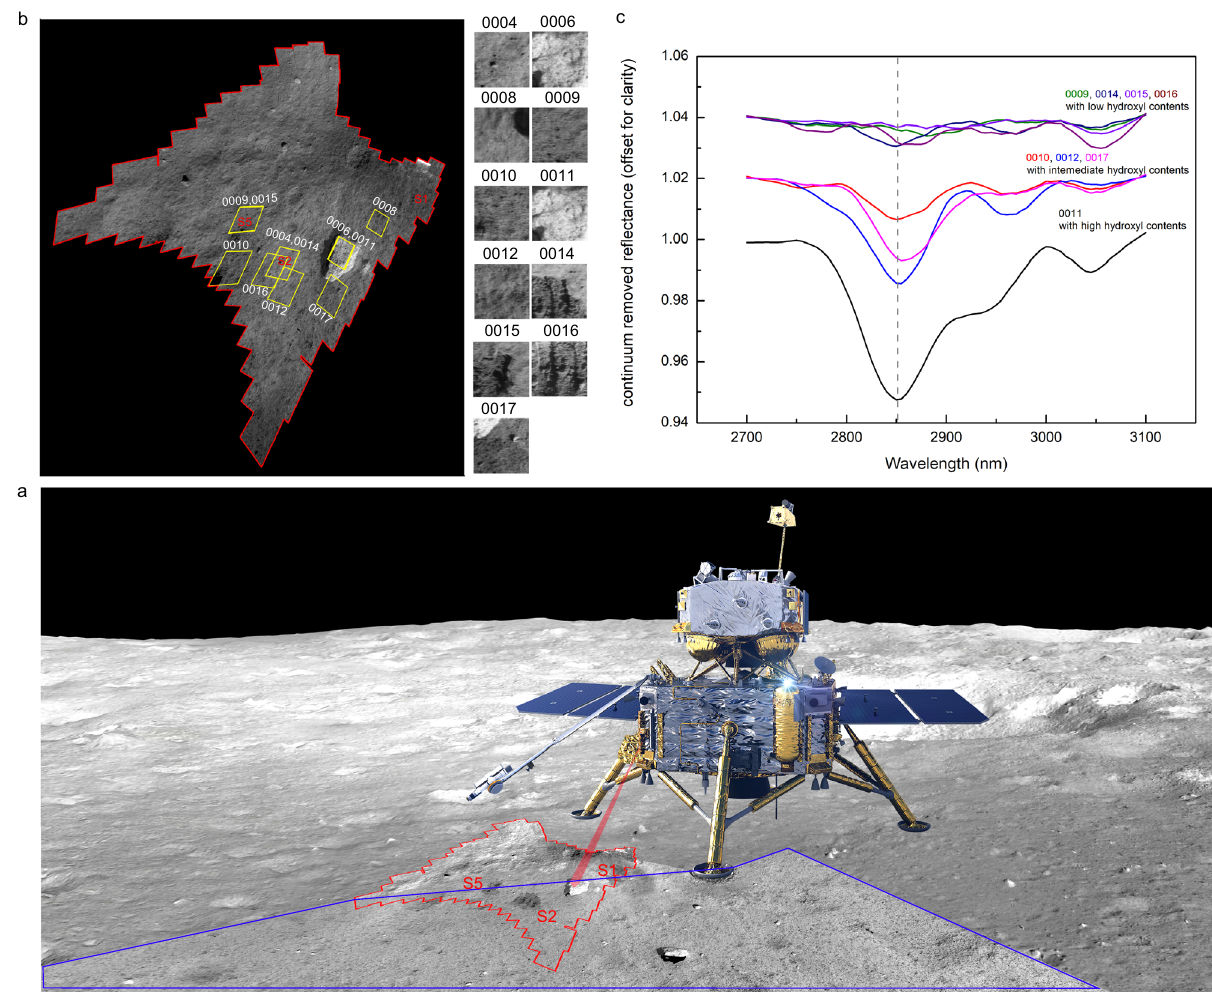
Fig. 1 Schematic diagram of the lunar mineralogical spectrometer (LMS) spectral data collection on the lunar surface and the 2700 – 3100nm absorption features of Chang ’ E-5 in situ spectra. a The area marked by the red line is the full view of LMS, S1, S2, S5 are the scoop sampling points, the blue box identi fi es the imaging area of the panoramic camera and the base image is from landing camera. b detailed positions and images of the LMS 11 Full-Bands Observation (FBO) detections. LMS operated twice at the S2 sampling point (detection number: 0004 and 0014), S5 sampling point (detection number: 0009 and 0015) and the large rock (detection number: 0006 and 0011) in the fi eld of view; the base map is composed of 180 images obtained by the LMS Full-View Scanning and Multispectral Observation (FVSMO) detections with a center wavelength of 750nm (More details see “ Methods ” ). c the 2700 – 3100 nm continuum removed absorption features of the 8 LMS FBO hyper-spectra (more details see “ Methods ” ). The gray dashed line shows the absorption positions near 2.85 μ m.